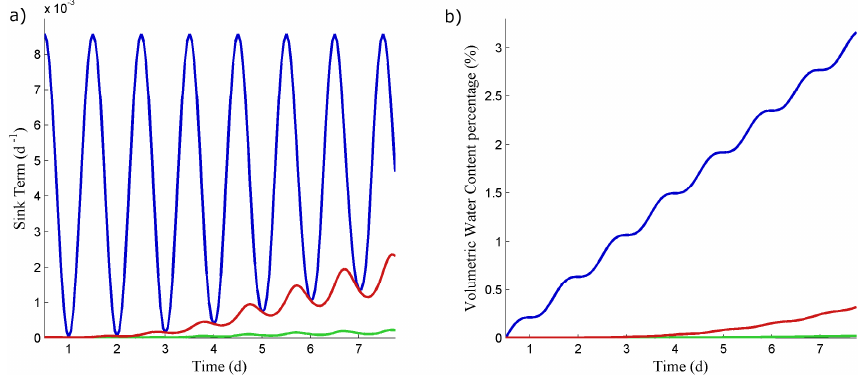
Fig. 9. Mean absolute differences between both explicit and implicit models predictions during the “CL” scenario. (a) Mean absolute sink term (blue), mean absolute difference on the sink term (green) and mean absolute difference on the sink term when K comp =0 (red). (b) Mean water content loss from the beginning of the simulation (blue), mean absolute difference on the water content (green) and mean absolute difference on the water content when K comp =0 (red).